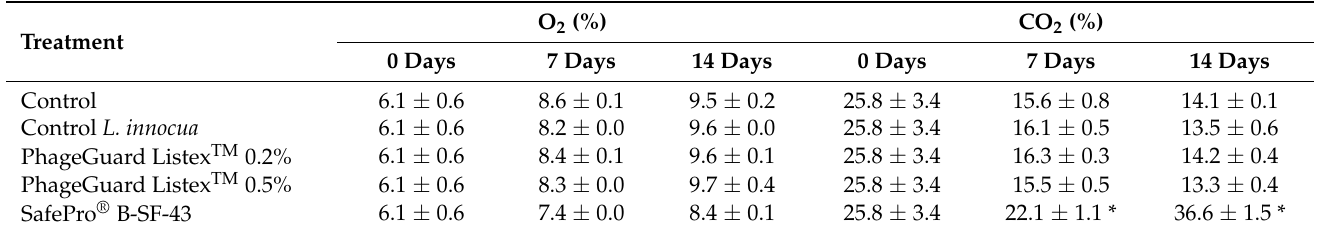
Table 1. The O 2 and CO 2 concentration in the trays of sliced cooked ham treated with biopreservation techniques and stored at 4 ◦ C under modified atmosphere packaging. Values are means ± standard deviations of three